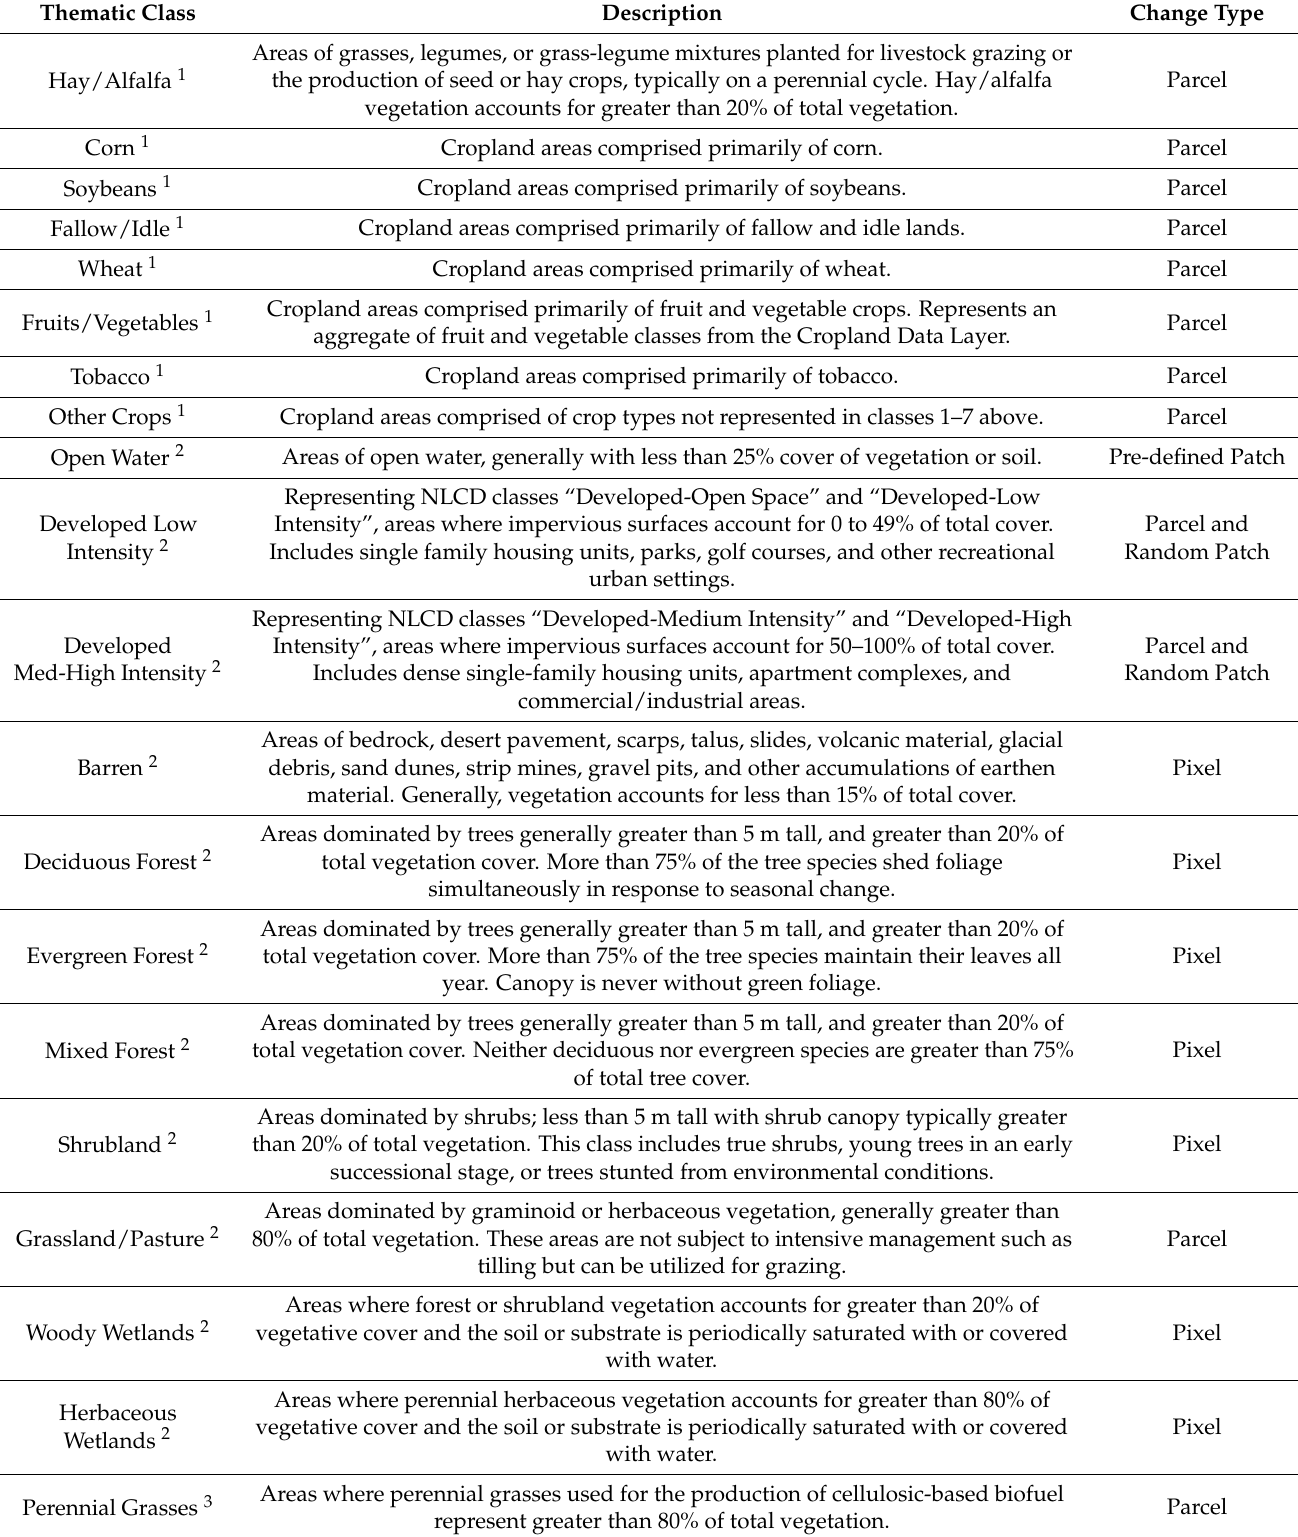
Table 1. Thematic land cover classes modeled for the Delaware River Basin (DRB). Classes represent a majority of National Land Cover Database (NLCD) 2016 classes, with major crop types from the US Department of Agriculture (USDA) Cropland Data Layer (CDL). Change type refers to spatial allocation method enacting landscape